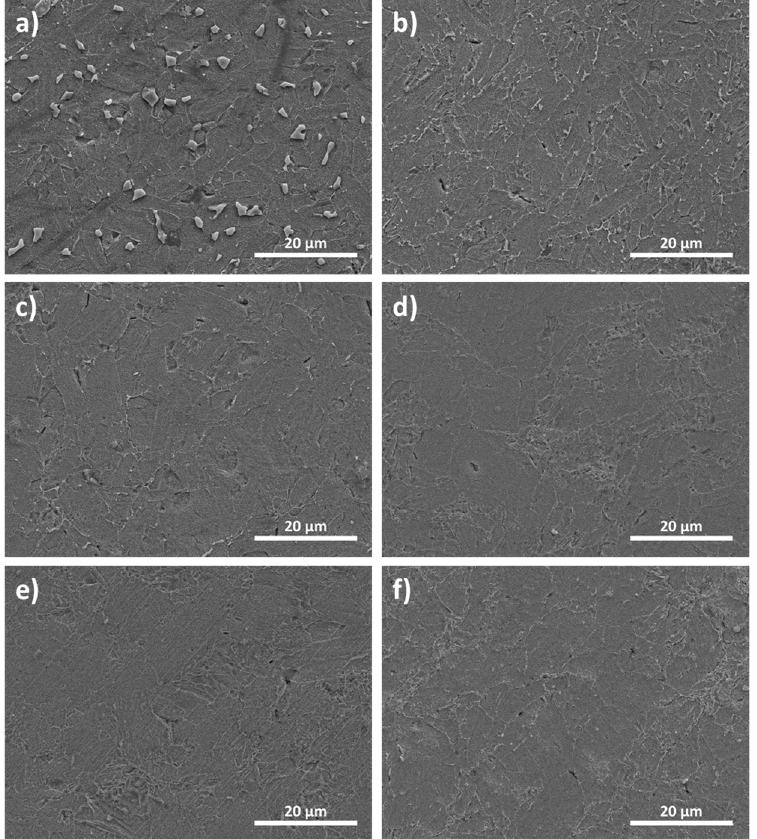
Figure 3. SEM cross-sectional micrographs of spark plasma sintered bulk samples obtained using heat treated powder at different temperatures: ( a ) 673 K, ( b ) 723 K, ( c ) 743 K, ( d ) 773 K, ( e ) 803 K, and ( f ) 823 K.